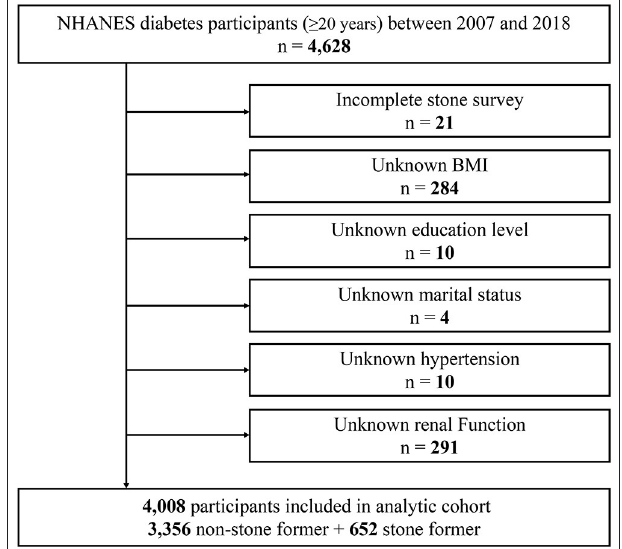
FIGURE 1 | Schematic overview for patient